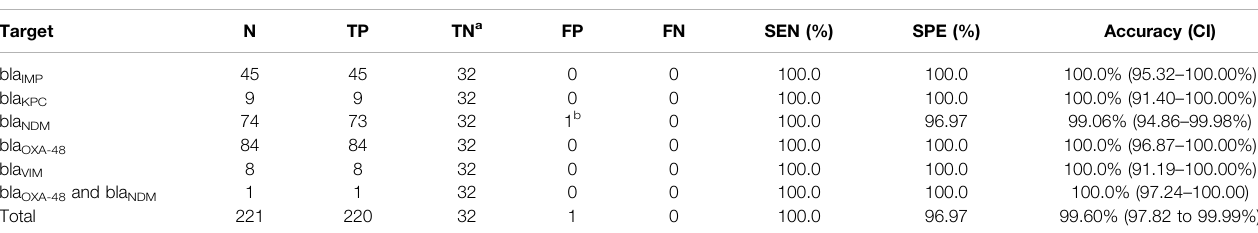
TABLE 5 | Classi fi cation of clinical isolates based on ML-based AMCA method. Target